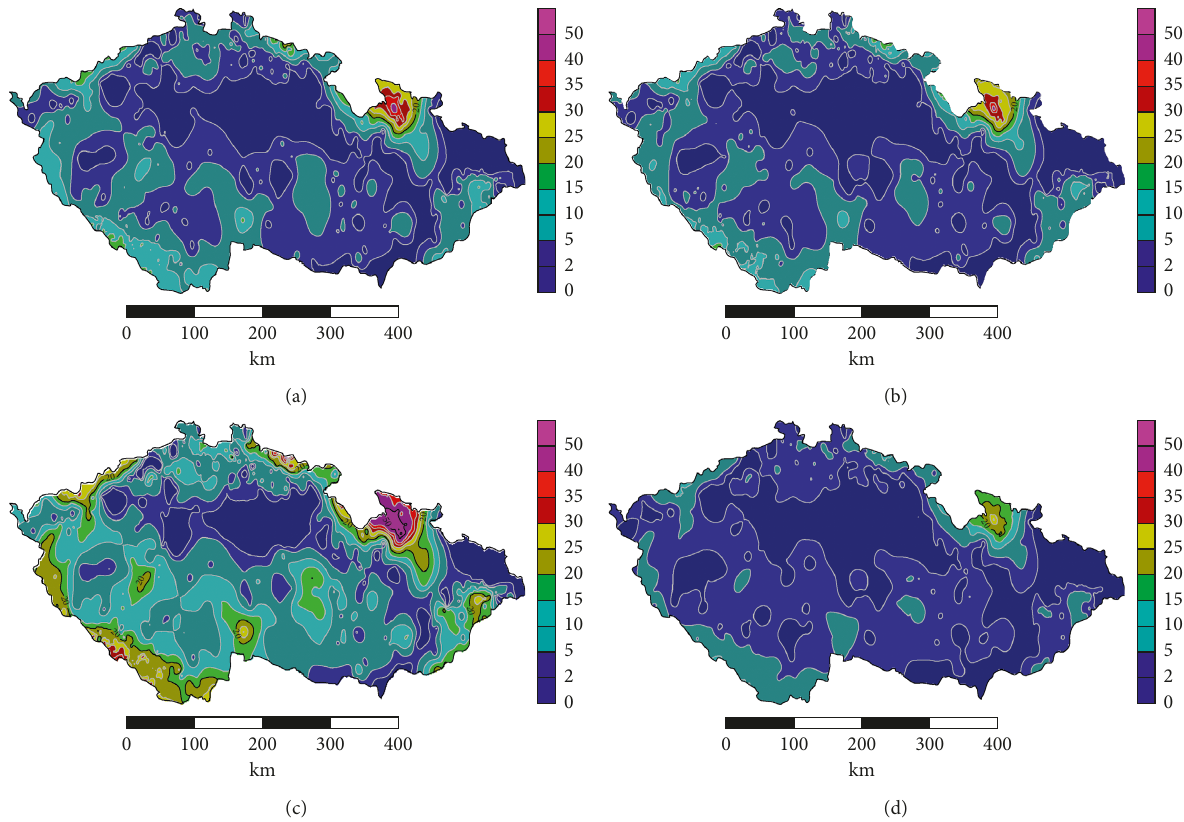
Figure 8: ASW outputs for (a) AAC, (b) ceramic brick, (c) hollow clay brick, and (d) sandstone